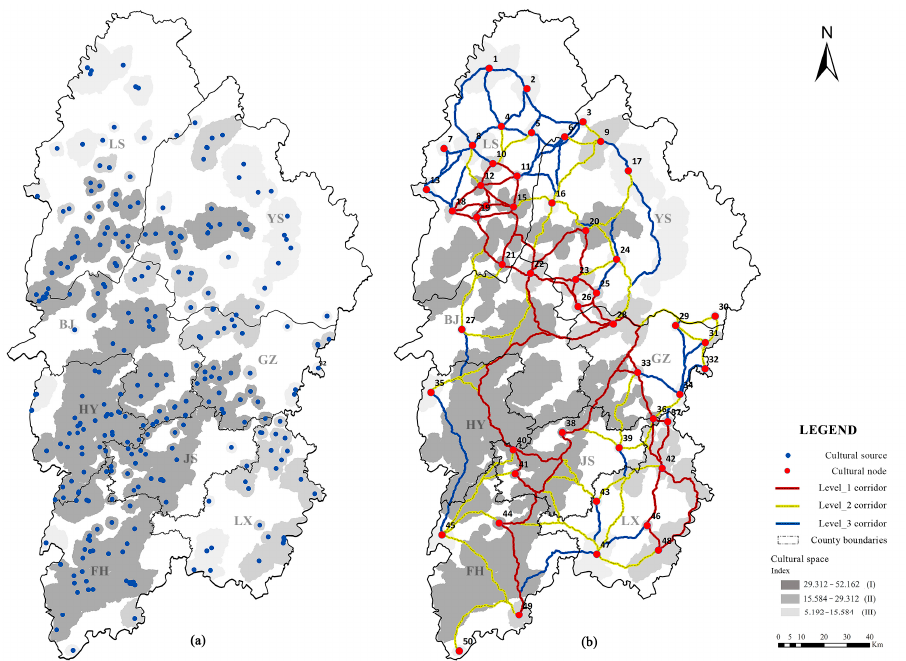
Figure 4. The spatial distribution of cultural space ( a ) and potential cultural heritage tourism corridor network ( b ).